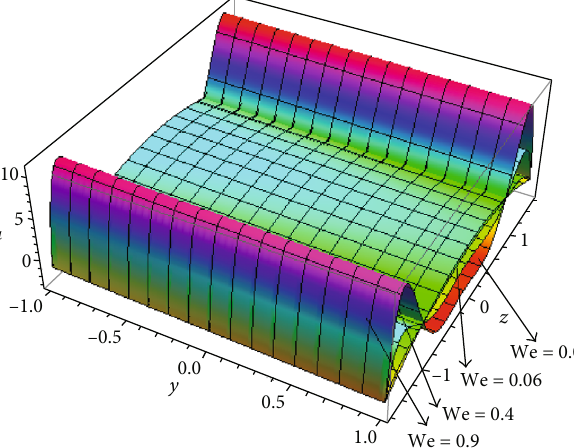
Figure 19: Velocity pro fi le for di ff erent values of We. The other parameters are φ = 0 : 6 , x = 0 , β = 0 : 9 , Q = 4 , and n = 2